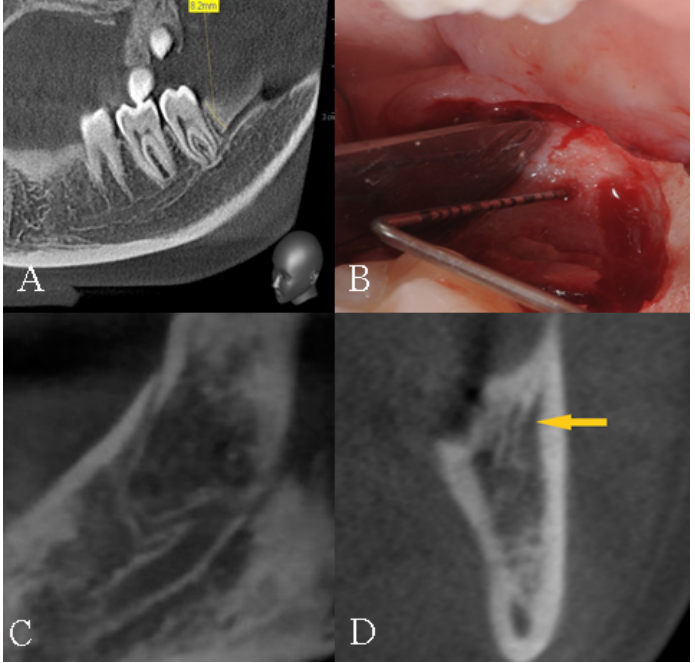
Figure 5. Type 1, retromolar canal: ( A ) sagittal view; ( B ) intraoperative view; ( C ) Panorex reconstruction; and ( D ) cross-section reconstruction. Arrow indicated the presence of the canal.